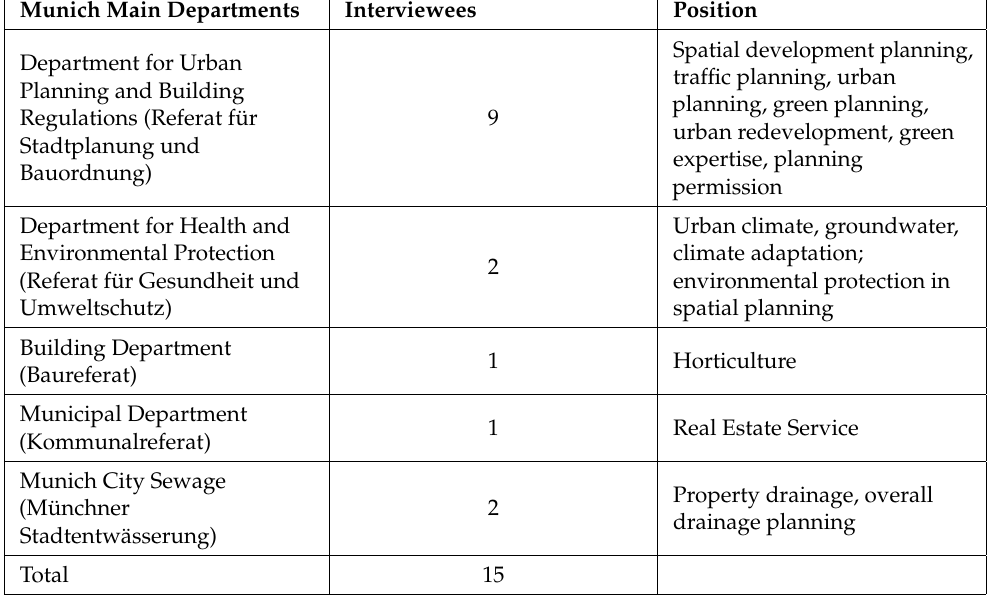
A table with the interviewees from the city administration.